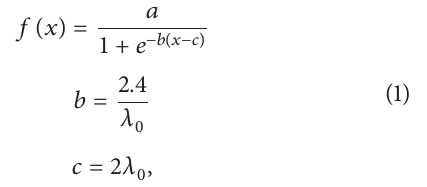
than 1.5 dB from 70 to over 110 GHz as shown in Figure